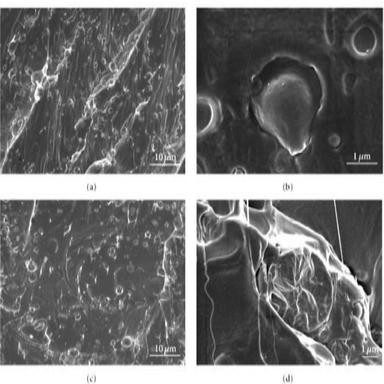
SEM images of PLA-G-CF dry mixing composite filaments.